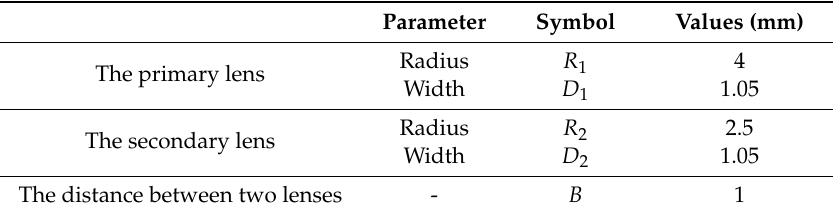
Figure 4. Device structure design of the focusing unit. Table 2. Design parameters of the focusing